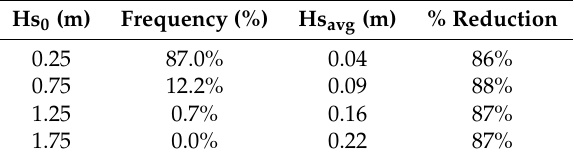
Table 1. Sensitivity of local wave heights (Hs avg ) to those at open boundary (Hs 0 ).